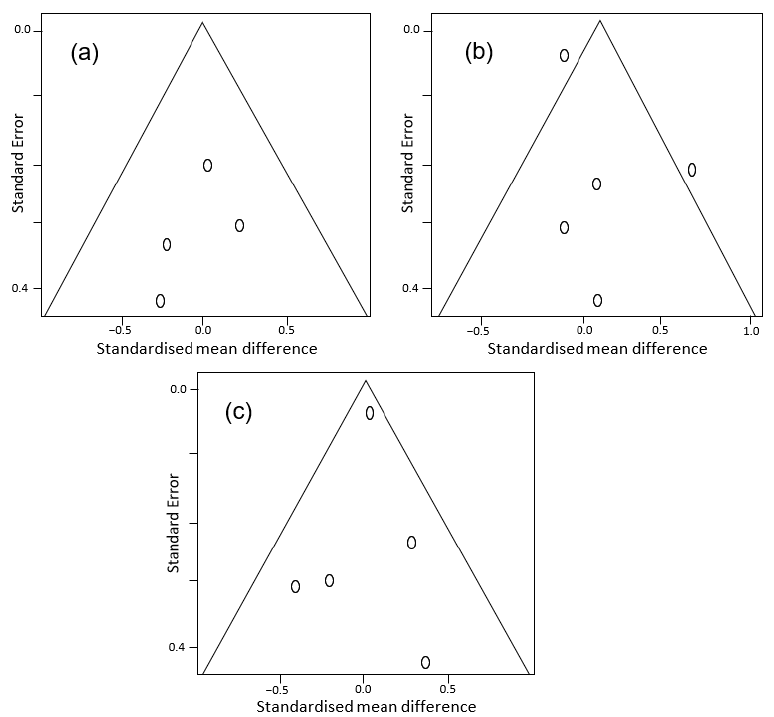
Figure 2. Funnel plots of cognitive domains: ( a ) complex attention, ( b ) executive function and ( c ) memory.